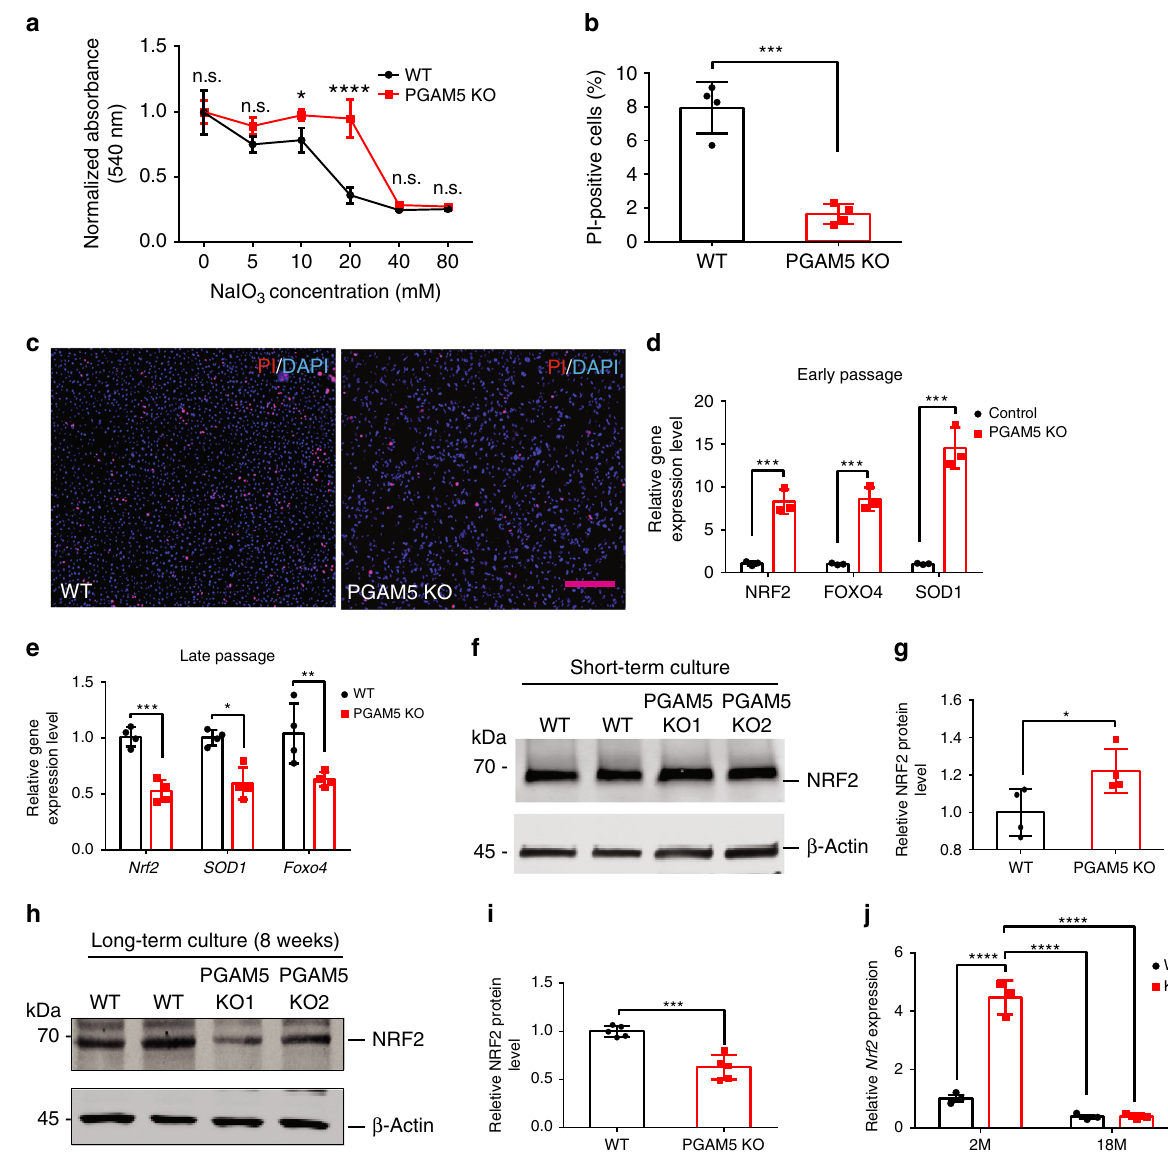
Fig. 8 Age-dependent regulation of anti-oxidative genes by PGAM5. a Cell survival by neutral red assay in WT and PGAM5 − / − ARPE-19 cells after overnight NaIO 3 treatment using indicated concentrations. n = 4, * p < 0.05, **** p < 0.0001, two-way ANOVA Tukey ’ s multiple comparisons test. Error bars, mean ± s.d. b Quanti fi cation of PI staining showing cell death in WT and PGAM5 − / − ARPE-19 cells after overnight NaIO 3 (10 mM) treatment using Nikon Elements software and ImageJ. n = 4, *** p = 0.0002, two-tailed unpaired t -tests, error bars, mean ± s.d. c Representative PI staining in b . Scale bar = 250 µ m. n = 4. d Upregulation of anti-oxidative genes ( NRF2 , FOXO4 and SOD1 ) in PGAM5 − / − ARPE-19 cells compared to control cells after short-term (1 week) culture. Data were normalized to GAPDH. n = 3, *** p = 0.001( Nrf2 ), p = 0.0007( Foxo4 ), p = 0.0006, two-tailed unpaired t- tests, error bars, mean ± s.d. e Downregulation of anti-oxidative genes ( NRF2 , FOXO4 and SOD1 ) in PGAM5 − / − ARPE-19 cells compared to control cells after long-term (8 weeks) culture. Data were normalized to GAPDH. n = 4, *** p = 0.0003; ** p = 0.0022; * p = 0.0258, two-tailed unpaired t -tests, error bars, mean ± s.d. f Upregulation of NRF2 protein in PGAM5 − / − ARPE-19 cells compared to control cells after short-term (1 week) culture. Data were normalized to β -actin. n = 4. g Quanti fi cation of data in f . n = 4, * p = 0.042, two-tailed unpaired t -tests, error bars, mean ± s.d. h Downregulation of NRF2 protein in PGAM5 − / − ARPE-19 cells compared to control cells after long-term (8 weeks) culture. Data were normalized to β -actin. n = 5. i Quanti fi cation of data in h . n = 5, *** p = 0.0003, two-tailed unpaired t -tests, error bars, mean ± s.d. j Nrf2 expression as measured by qRT-PCR in the RPE/choroid of WT and Pgam5 − / − mice at 2 and 18-months old. Data were normalized to Gapdh . n = 3, **** p < 0.0001, two-way ANOVA Tukey ’ s multiple comparisons test. Error bars, mean ± s.d. For assays in the fi gure, n represents the number of biologically independent experiments unless otherwise speci fi ed. Images were captured under same settings, and representative images were shown. Source data are available as a Source Data fi mTORC1 via AMPK-TSC2 pathway, which leads to senescence, constitutively active form of Drp1, rescues the marker expression eventually low ATP production. Consistently, we found that and phenotypes above in PGAM5 − / − cells. These establish a causal relationship between mitochondrial hyperfusion and overexpression of Drp1-K38A mutant, an inactivated form of senescence, and a critical role for Drp1 in mediating PGAM5 Drp1, phenocopies the ATP upregulation, mTOR activation and function in senescence. ROS increase in PGAM5 − / − cells does not senescence caused by PGAM5 deletion. Drp1-S637A mutant, a